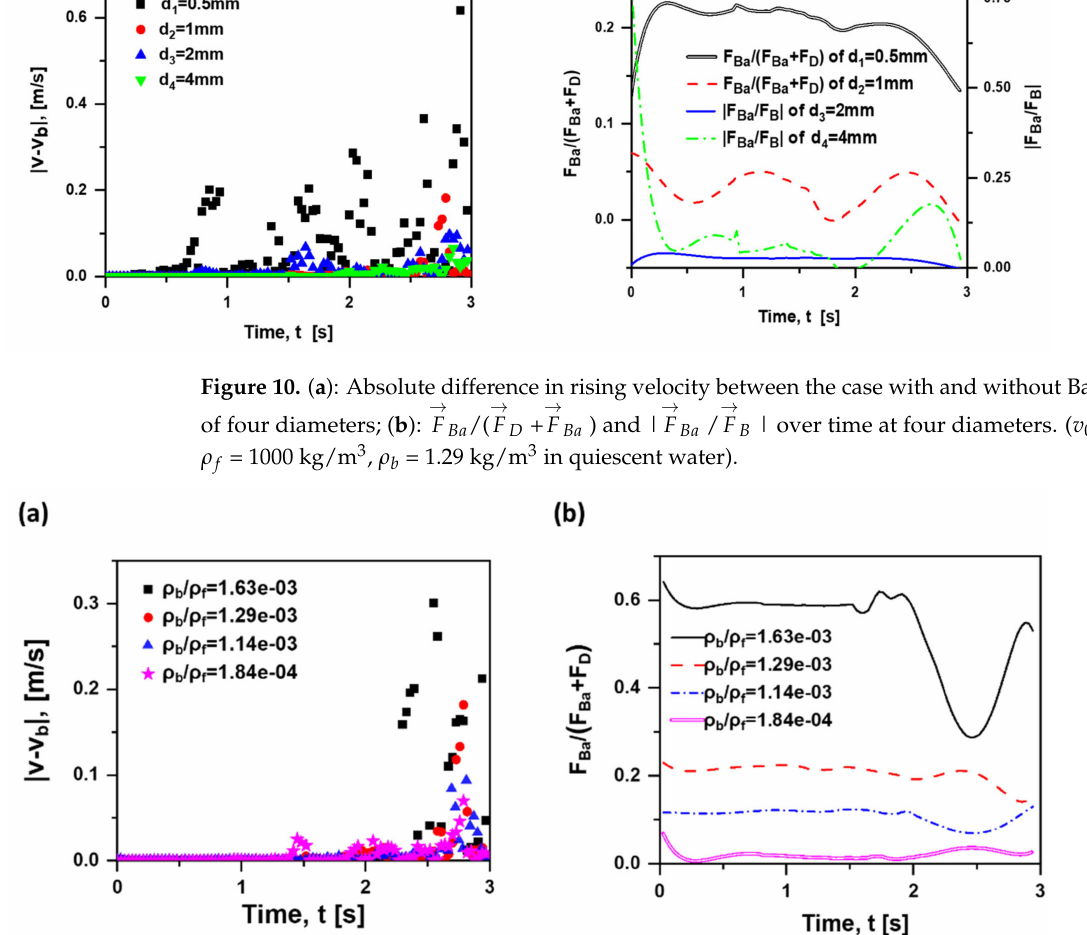
Figure 11. ( a ): Absolute difference in rising velocity between the case with and without Basset force → → → F Ba /( F D + F Ba ) over time of three density ratios ( v 0 = 0 m/s, d b = 1 mm, of three density ratios; ( b ) ρ b = 1.29 kg/m 3 in quiescent